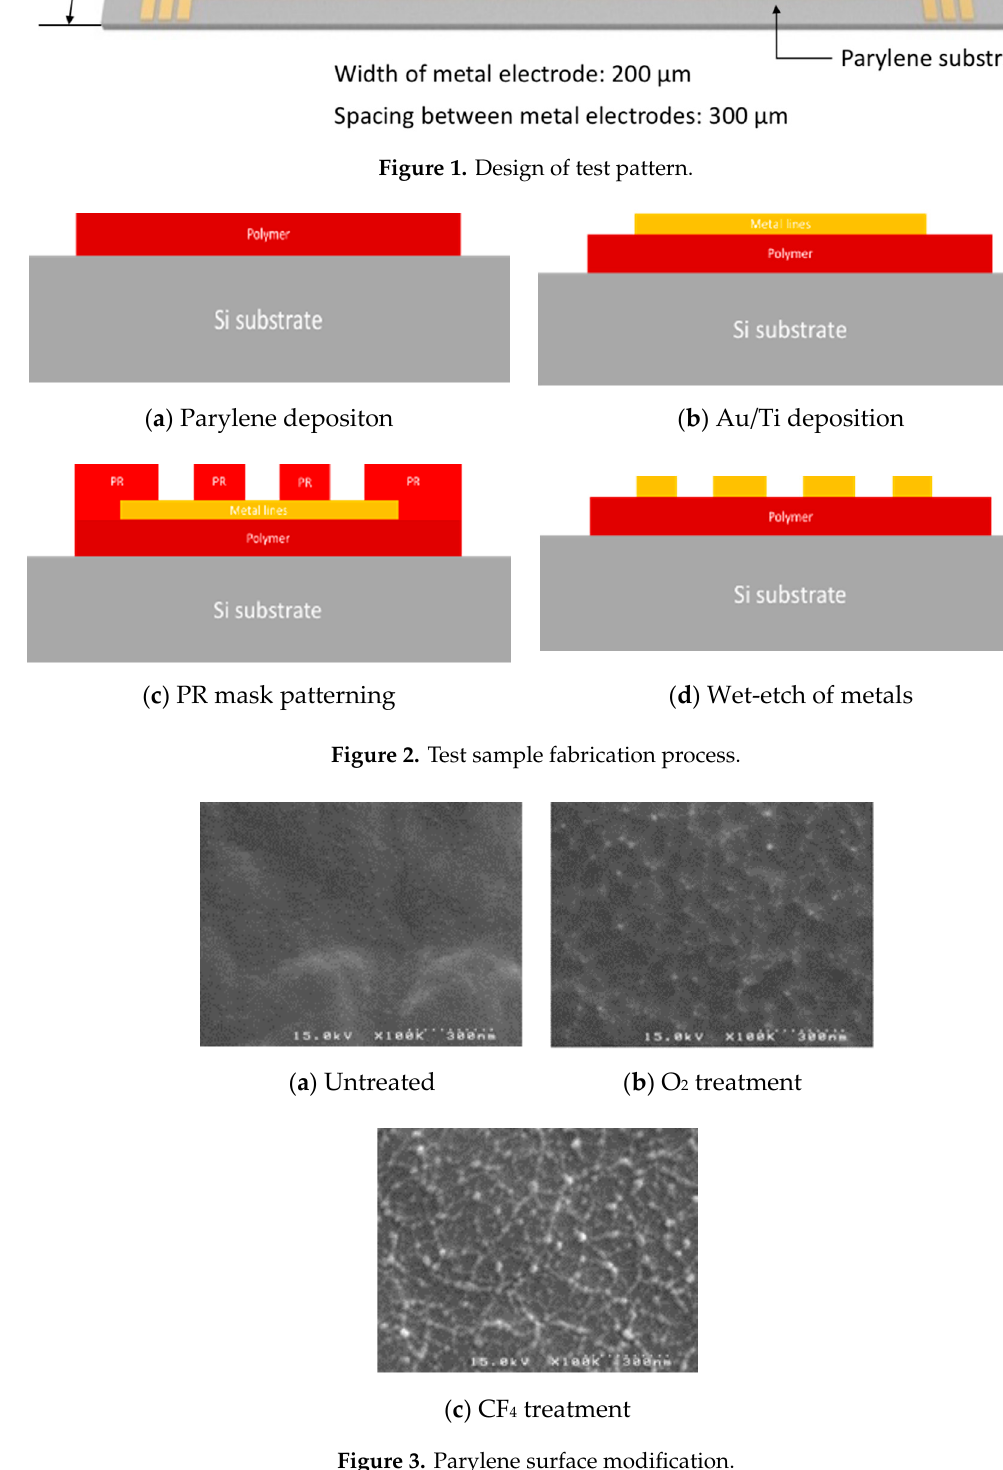
Figure 3. Parylene surface modification.